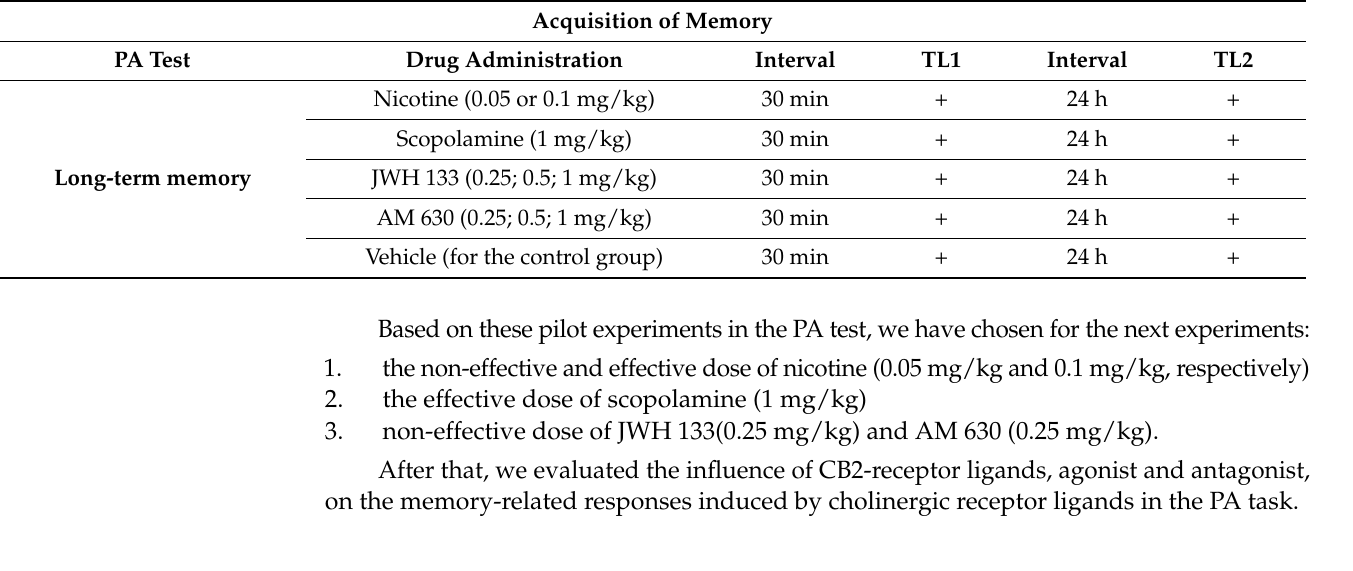
Table 1. The scheme of cholinergic and CB2-receptor ligands or vehicle administration during the assessment of long-term memory acquisition in the PA test in